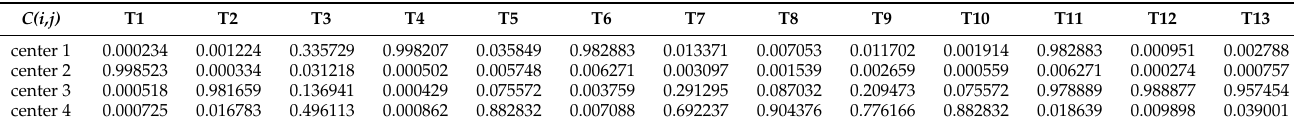
Figure 13. First derivative graph of the objective function. Table 2. Fuzzy membership